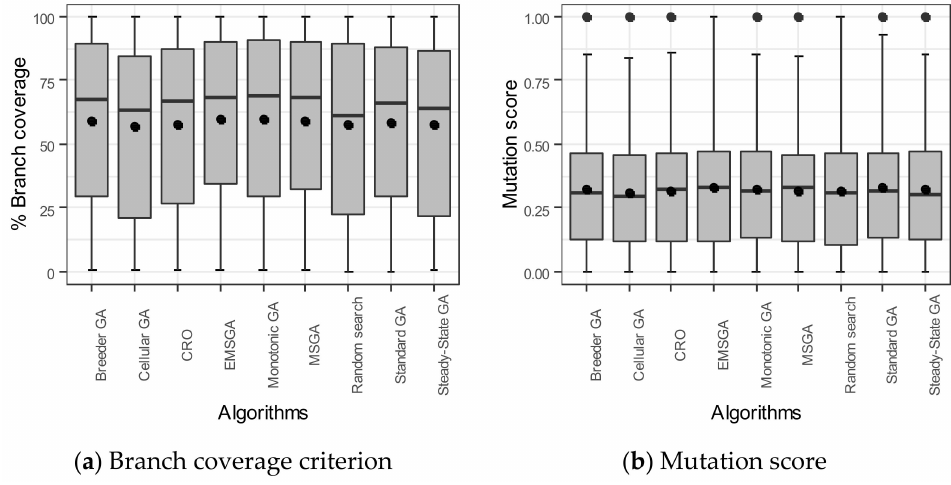
Figure 4. Coverage and mutation scores achieved by each